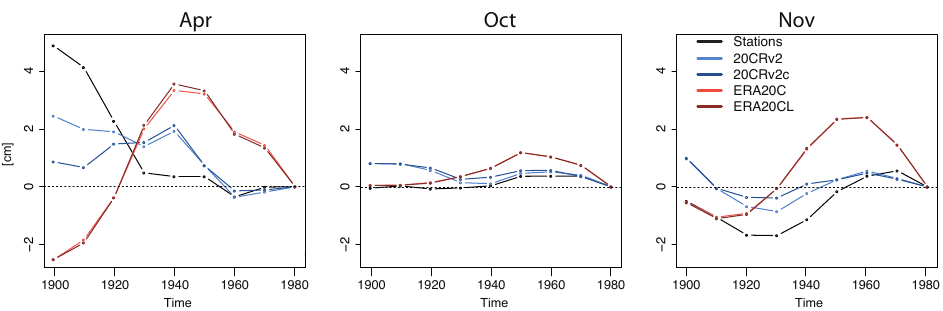
Figure 4. Top: time series of snow depth anomalies in (from left to right) April, October and November for the average of the 13 station locations. Each data point represents a 30-year-long climatology, starting from 1901–1930 until 1981–2010, with 10 year shifts. Anomalies are calculated relative to the 1981–2010 climatology. ERA-20C is labeled as ERA20C, and ERA-20C land is labeled as ERA20CL.